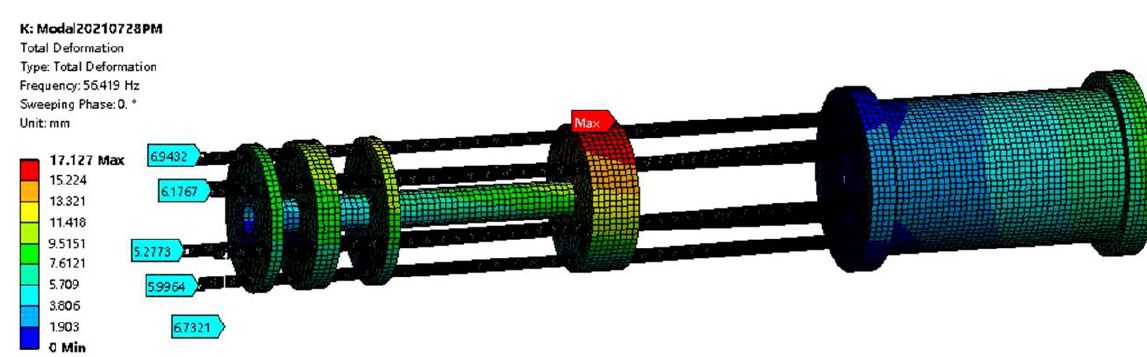
Figure 24. L value of 200 mm in M134.